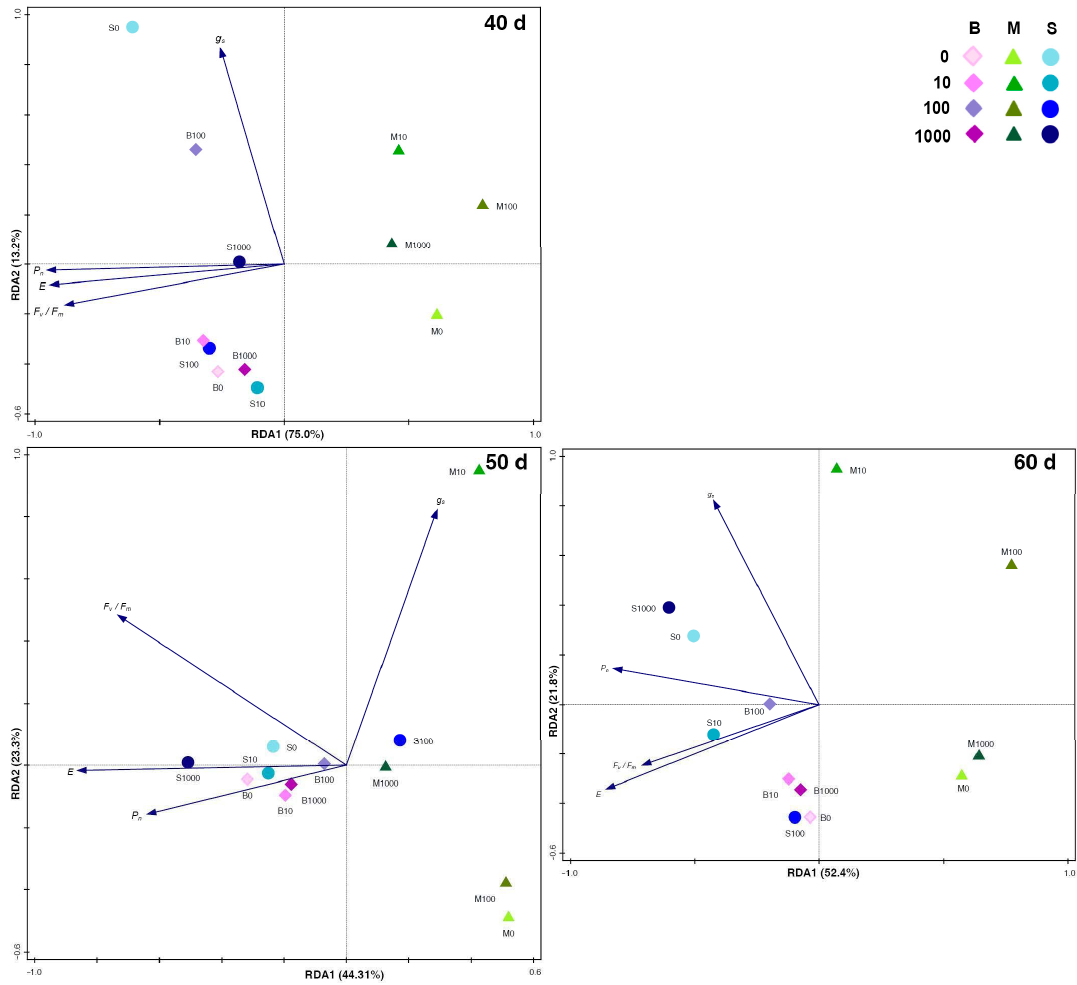
Figure 3. Ordination diagram (RDA—Redundancy analysis). The biplot displays the varieties with different GA 3 concentrations. The explained variability is shown for the axes in the figures. The GA 3 concentration is shown by the color intensity of the symbol that represents varieties (table in graph).